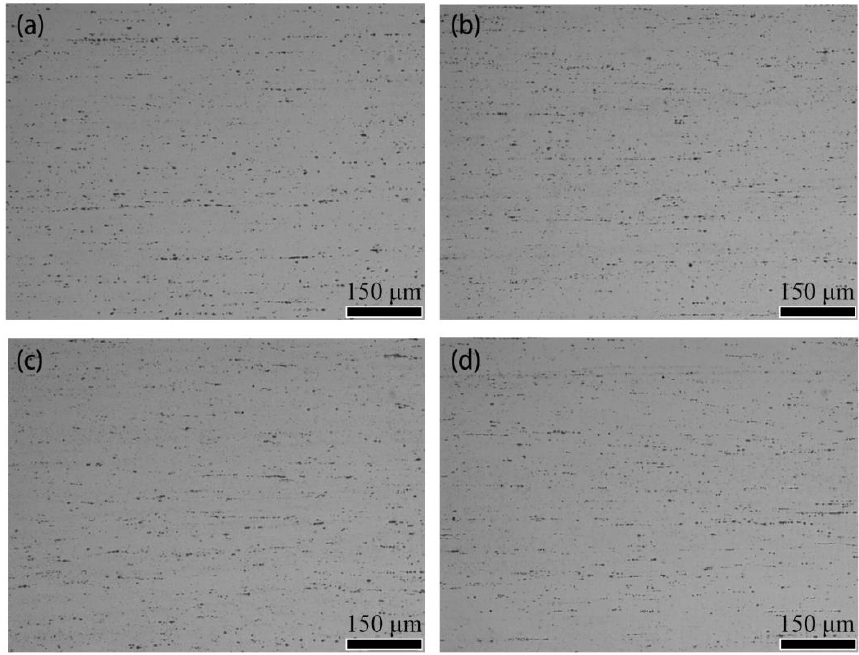
Figure 2. Optical microstructure of quenched Al-(2.86~9.41) Mg alloy sheet with different Mg con- tents (undecked). ( a ) x = 2.86% Mg; ( b ) x = 4.23% Mg; ( c ) x = 6.51% Mg; ( d ) x = 9.41%